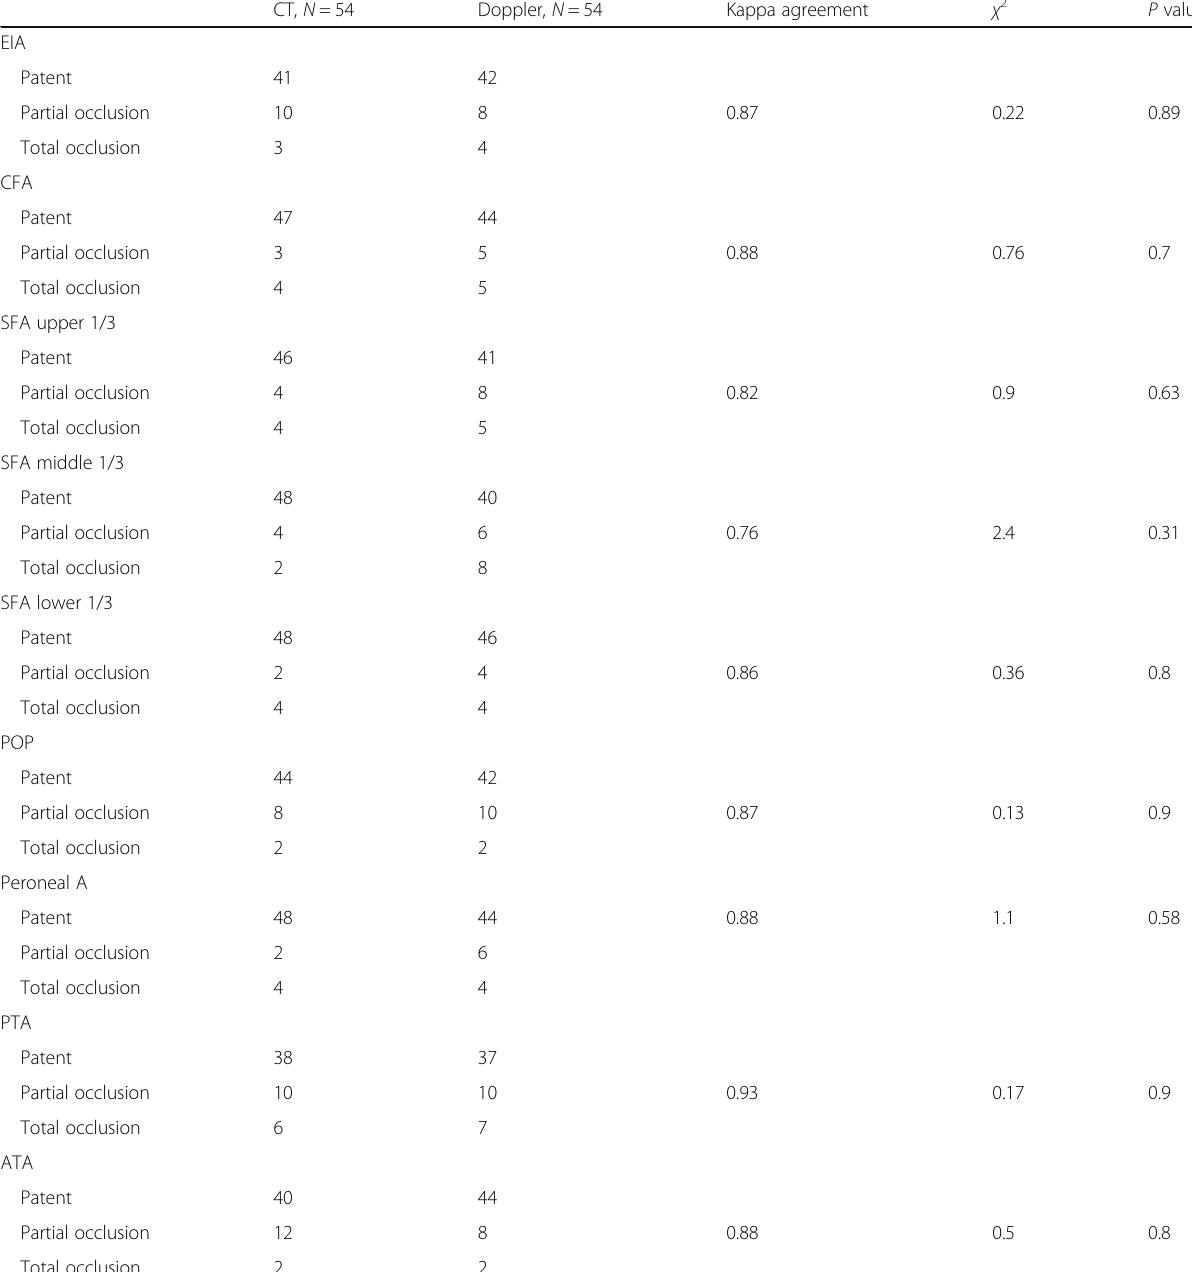
Table 2 Reliability and agreement between CT and Doppler techniques in the detection of vascular